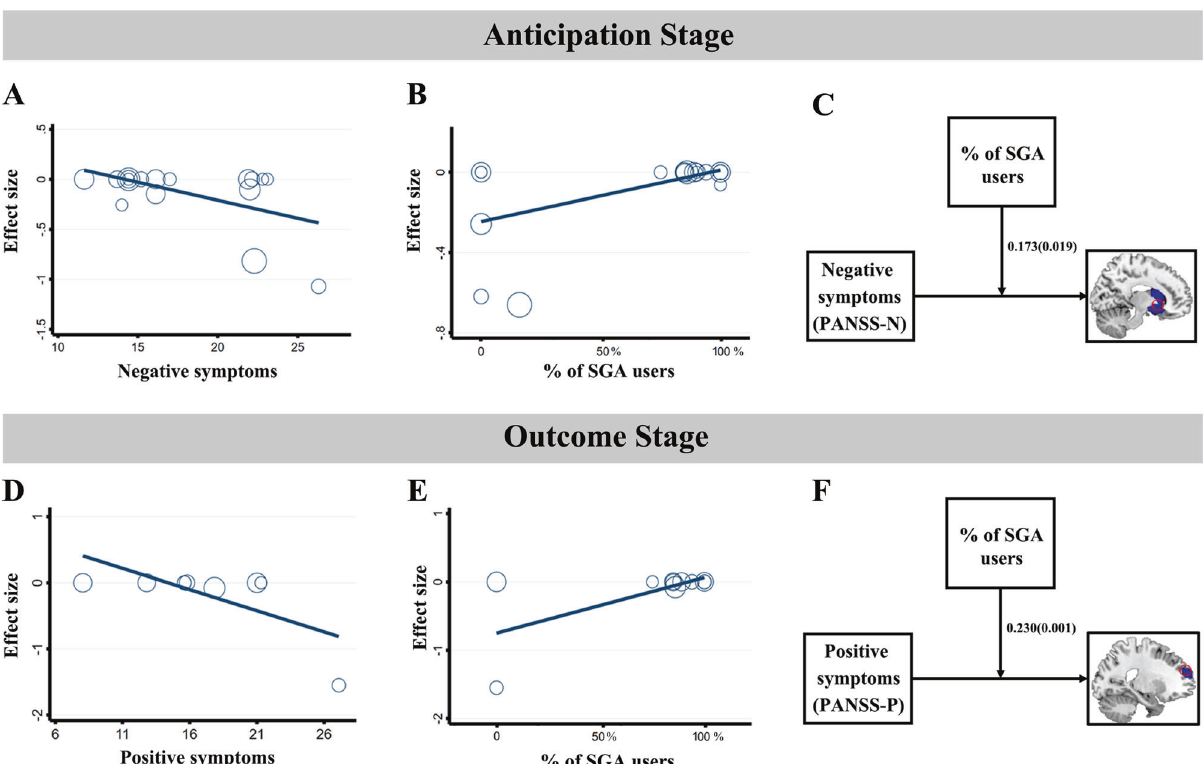
Fig. 3 Correlations and moderation analyses between clinical symptoms and brain activity during reward anticipation and reward outcome. A Scatter plot showing a signi fi cant negative association between anticipation-evoked activity and negative symptom severity (PANSS-N) in the VS (MNI coordinates: x = 16, y = 14, z = − 6, r = − 0.507, p = 0.038). B Scatter plot showing a signi fi cant positive association between anticipation-evoked activity and the % (percentage) of SGA users (the proportion of SZ who had ever received SGA) in the VS (MNI coordinates: x = 16, y = 2, z = 0, r = 0.533, p = 0.019). C Conceptual diagram of the moderating effect of the % of SGA users on the relationship between negative symptoms and striatum hypoactivation during reward anticipation. D Scatter plot showing a signi fi cant negative association between outcome-evoked activity and the positive symptom severity (PANSS-P) in the mPFC (MNI coordinates: x = 0, y = 46, z = − 10, r = − 0.681, p = 0.043). E Scatter plot showing a signi fi cant positive association between outcome-evoked activity and the % of SGA users in the mPFC (MNI coordinates: x = 0, y = 46, z = − 10, r = 0.656, p = 0.028). F Conceptual diagram of the moderating effect of % of SGA users on the relationship between positive symptoms and mPFC hypoactivation during reward outcome. SZ schizophrenia, HC healthy controls, SGA second-generation antipsychotic, mPFC medial prefrontal